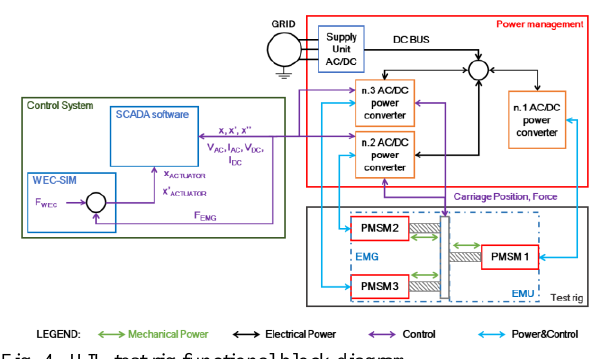
Fig. 4. HIL test rig functional block